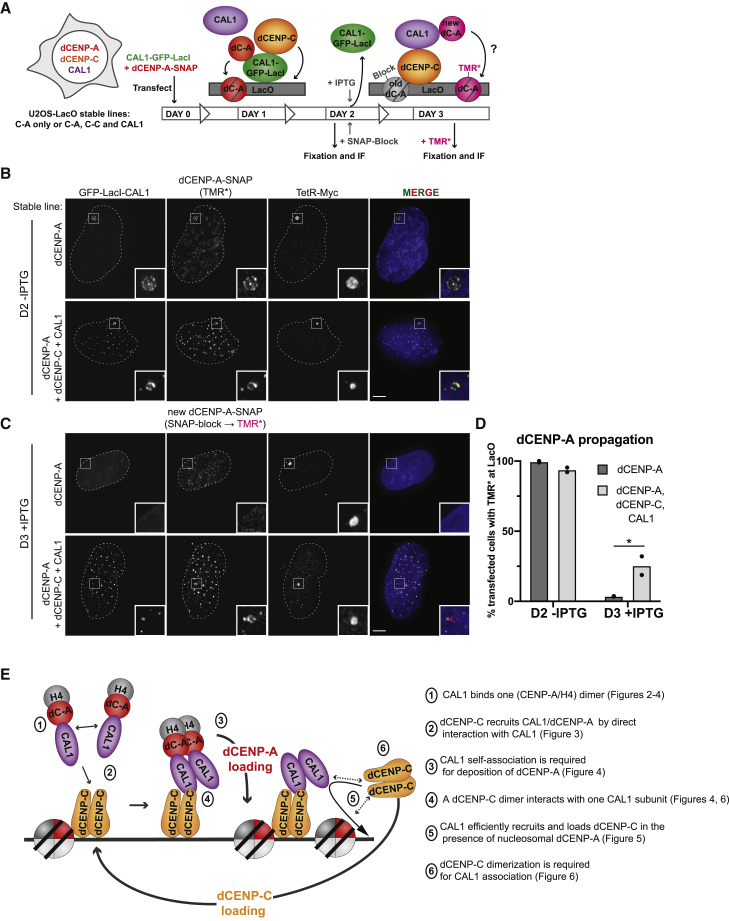
Drosophila dCENP-A Can Be Propagated at Ectopic Sites on Human Chromosomes(A) Experimental procedure to test epigenetic inheritance of dCENP-A in human cells. 48 h (day 2) after transfection of Cal1-GFP-LacI and dCENP-A-SNAP, cells were either stained with TMR∗ and subjected to IF or incubated with IPTG to remove CAL1-GFP-LacI binding and SNAP-Cell Block to quench existing SNAP-dCENP-A molecules. After further culturing for 24 h, cells were incubated with TMR-Star to stain newly synthesized SNAP-dCENP-A (day 3).(B and C) Representative IF images of the recruitment of dCENP-A to the LacO arrays 2 days (B) or 3 days (C) after transfection of CAL1-GFP-LacIw and dCENP-A-SNAP in U2OS-LacO stable cell line expressing all three Drosophila centromeric proteins or only dCENP-A. Insets show magnification of the boxed regions. Scale bar, 5 μm.(D) Quantification of the percentage of cells with TMR∗ signal at the LacO using imaging data of (B) and (C). Two experiments (dark circles) and their average (column) are shown. ∗p < 0.05. (See also Figure S7).(E) Model for centromere epigenetic inheritance in Drosophila. For dCENP-A (C-A in red) loading, a dCENP-C dimer (in orange) recruits a CAL1 dimer (in purple) in complex with 2× (dCENP-A/H4). For dCENP-C recruitment, one subunit of the CAL1 dimer is available for recruiting a soluble dCENP-C dimer, which is stabilized at the chromatin by dCENP-A nucleosomes.